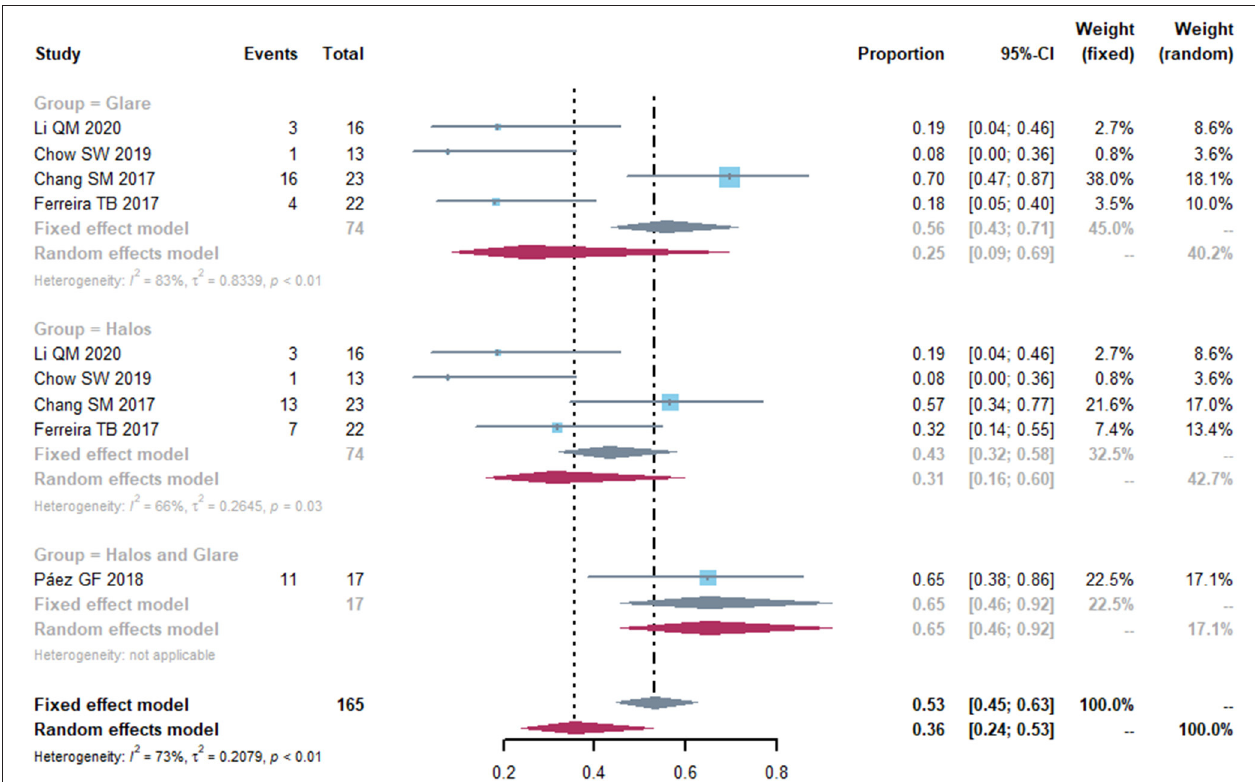
FIGURE 6 | Forest plot of photic disturbance of halos and glare. Total, total number of the patients. Proportion, proportion of patients who suffered from halos and